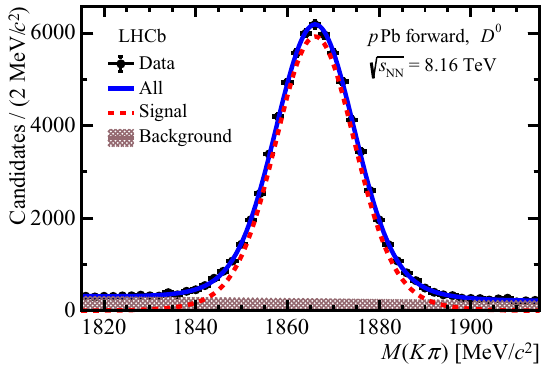
Figure 3. Fit to the invariant mass distribution of D 0 candidates from p Pb collisions at √ s NN = 8 TeV,